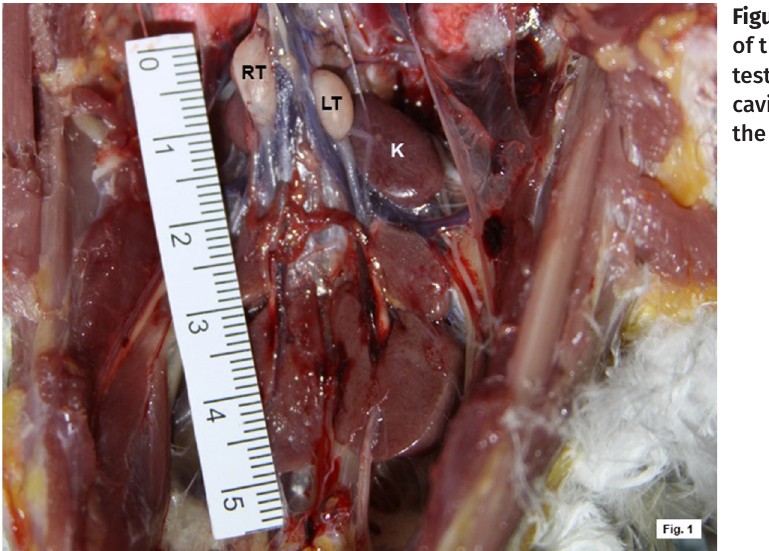
Figure 1. Anatomical location of the right (RT) and left testicle (LT) in the celomatic cavity, cranio-ventrally about the kidneys (K).